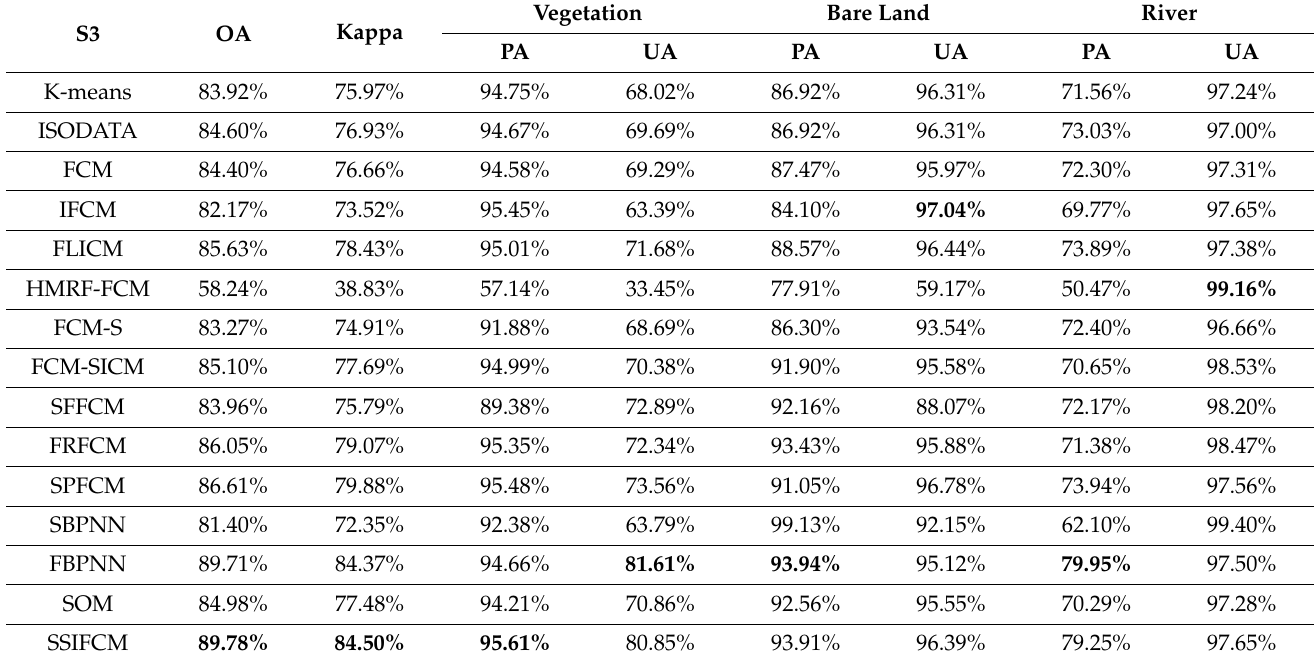
Table 7. Evaluation of S3 image